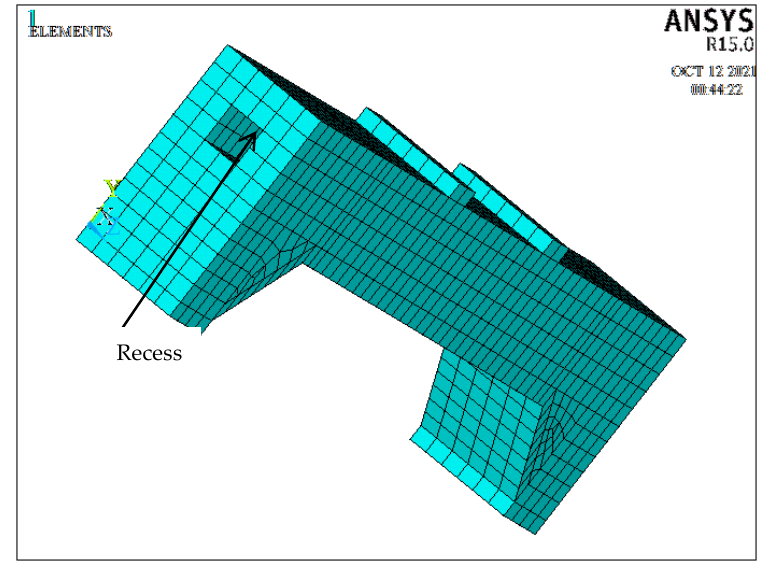
Figure 6. 3D view of typical meshed hollow beam model.